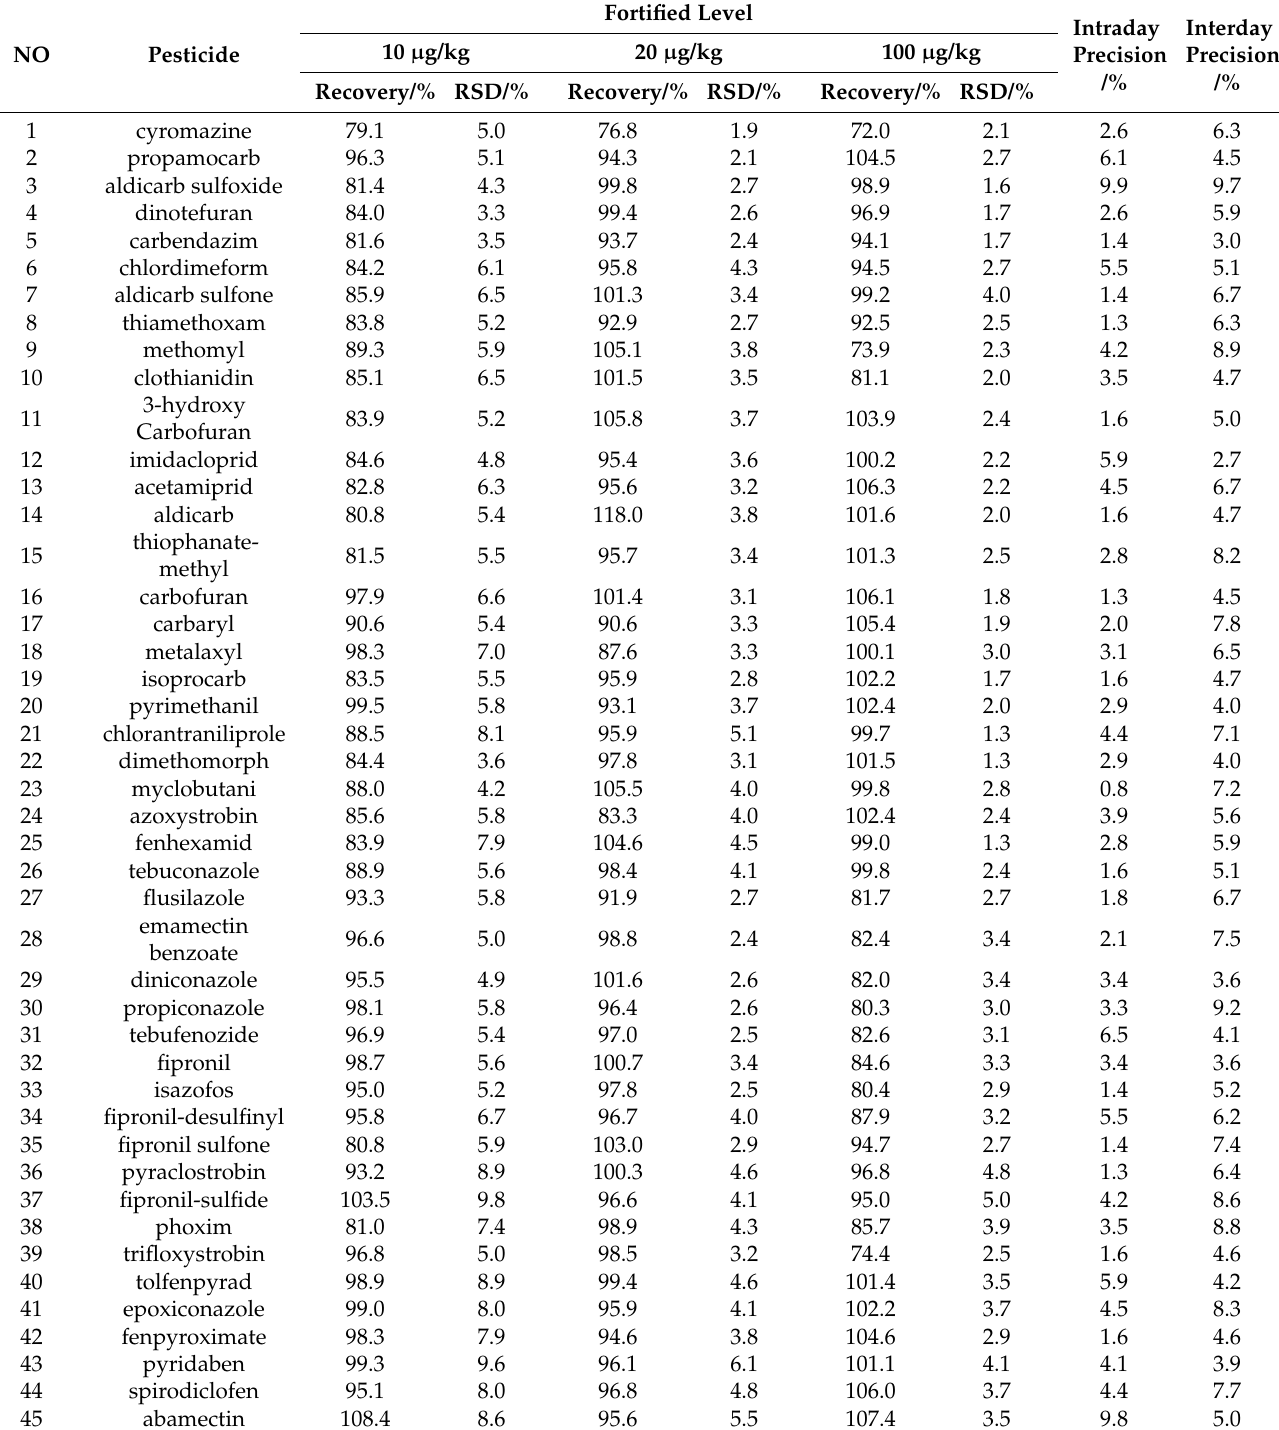
Table 2. UPLC-MS/MS fortifcation experiments (recovery and repeatability) at 10 µ g/kg, 20 µ g/kg and 100 µ g/kg fortifcation